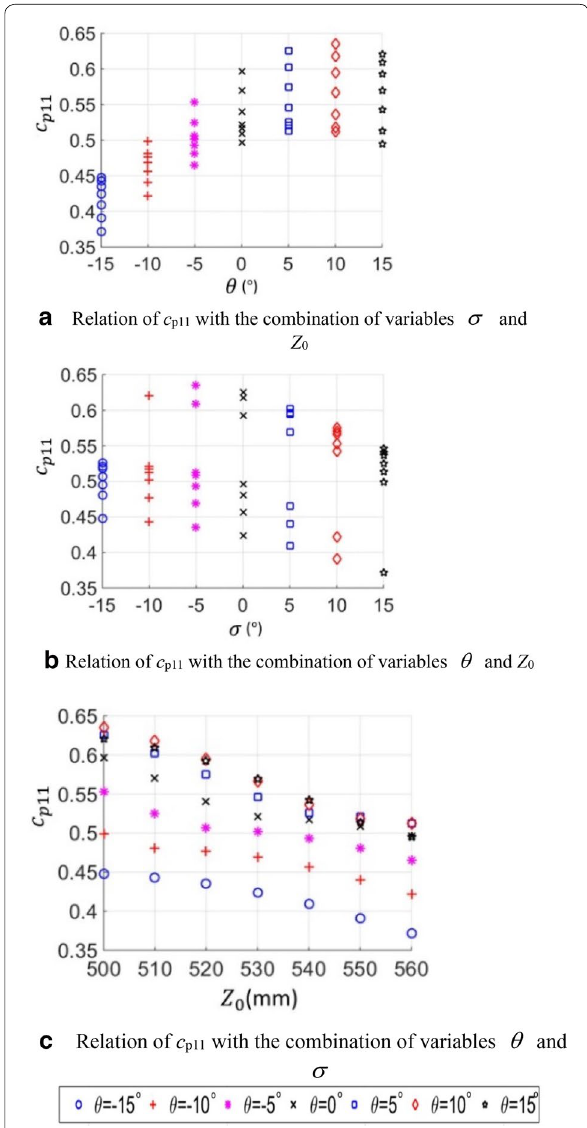
Figure 6 Relation of c p11 with the combination of any two variables of θ , σ , Z